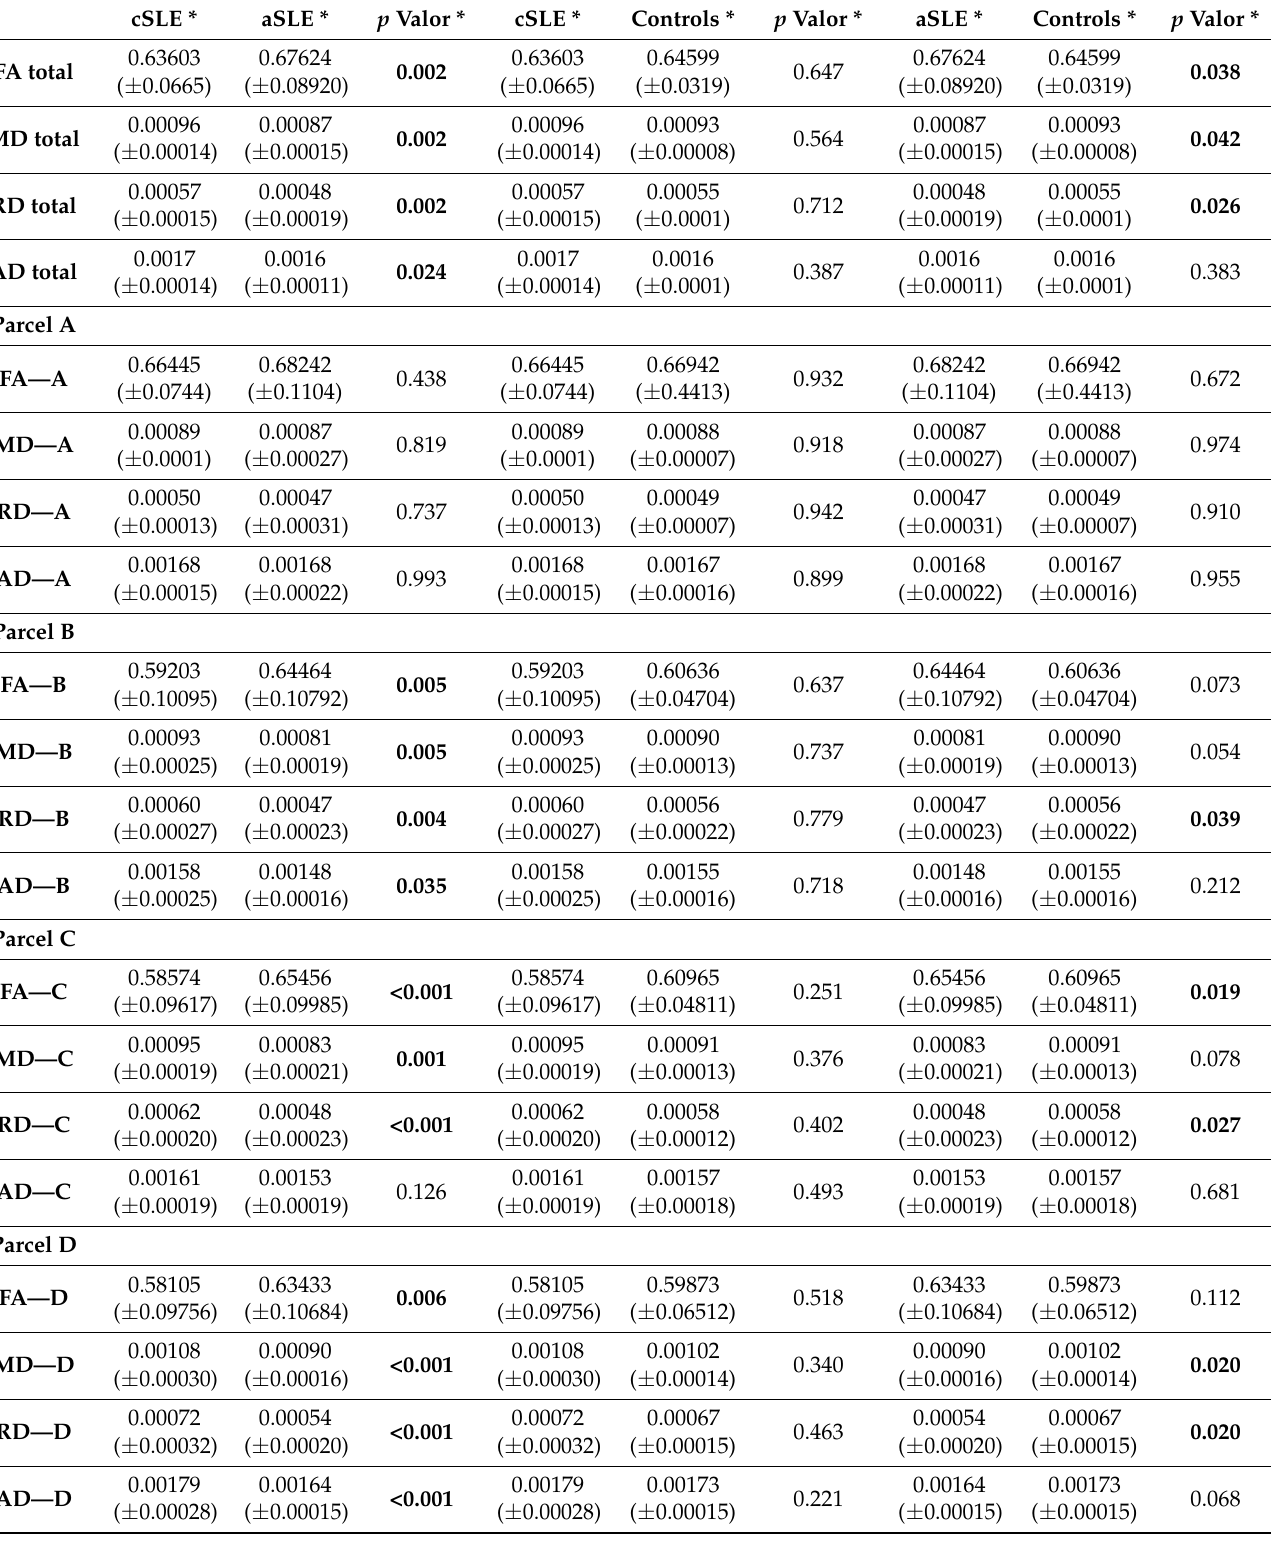
Table 2. DTI-based scalar maps in the entire corpus callosum and different